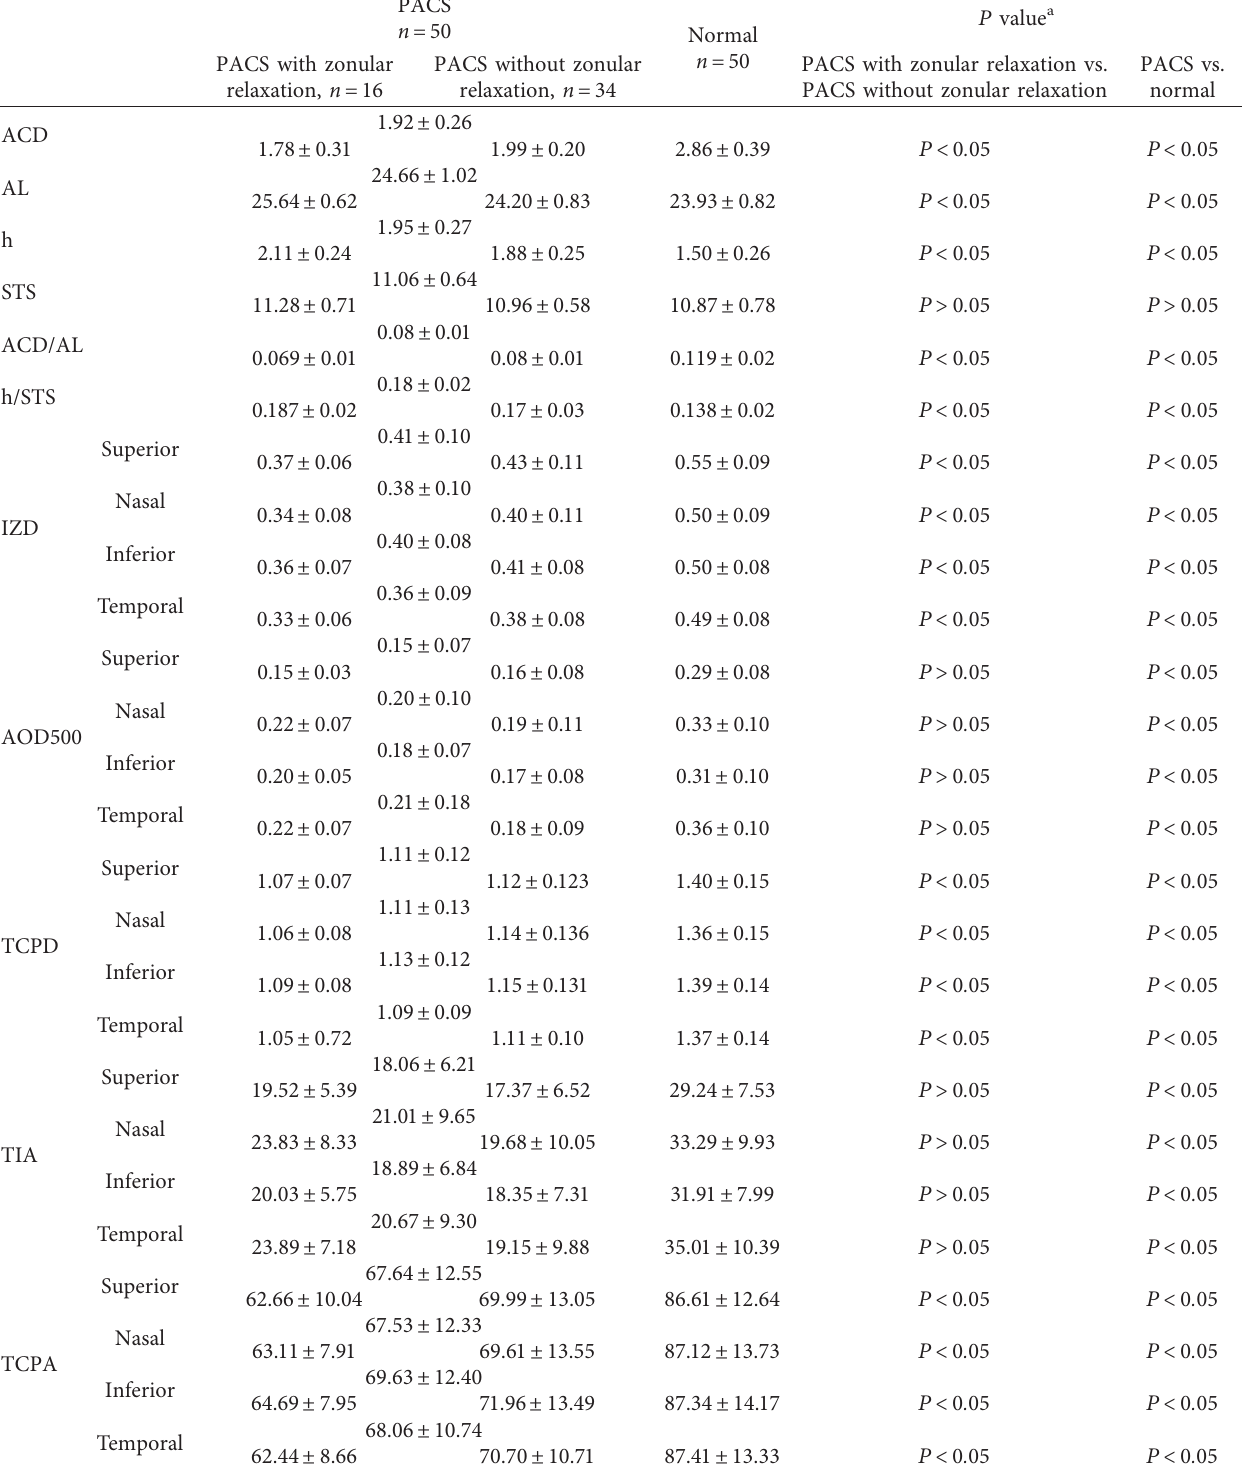
Table 2: Comparison of parameters among 16 PACS with zonular relaxation, 34 PACS without zonular relaxation, and 50